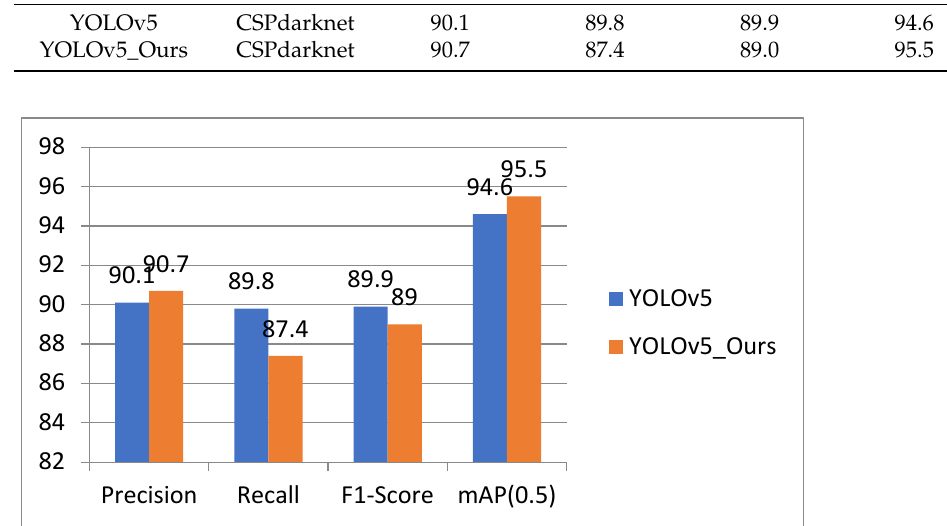
Figure 11. Comparison graph of result values for Original YOLOv5 and YOLOv5_Ours model.